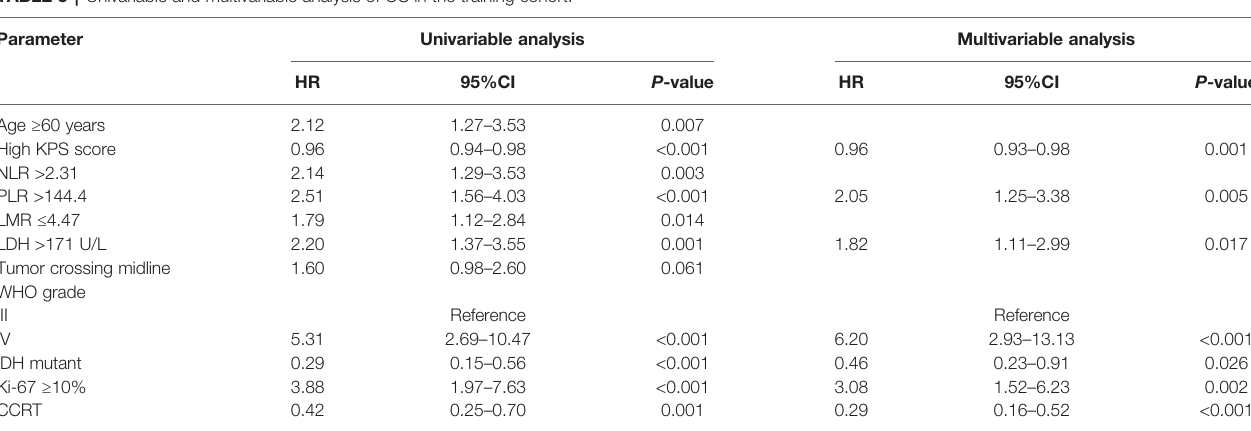
TABLE 3 | Univariable and multivariable analysis of OS in the training cohort.